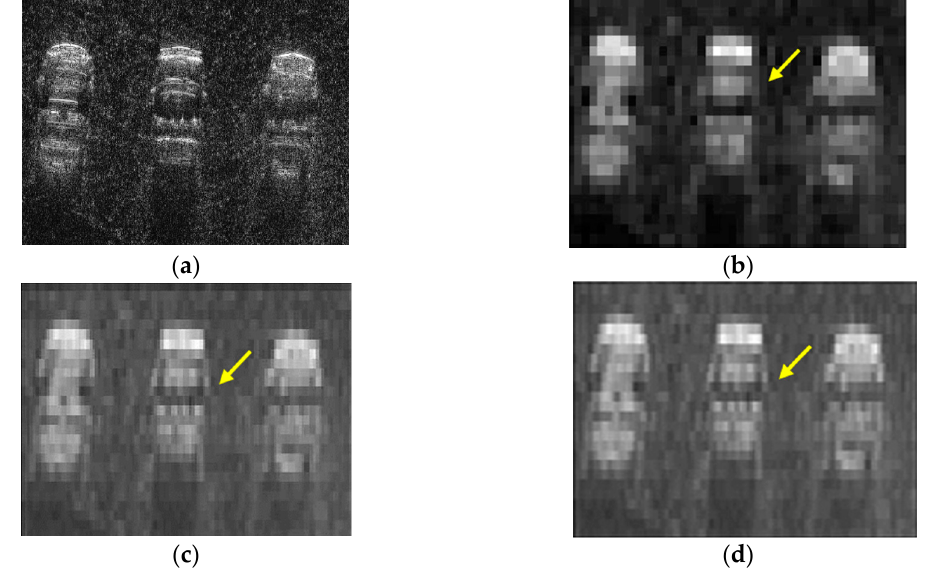
Figure 12. Multi-target simulations of the ( a ) referential airborne synthetic aperture radar image with 0.02 m resolution; ( b ) emulated single-track image; ( c ) emulated image enhanced by the azimuth super-resolution method; and ( d ) spotlight, emulated spotlight image.